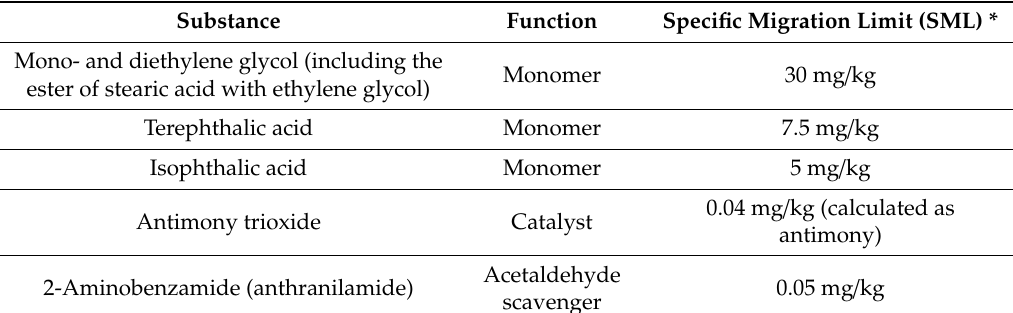
Table 1. Specific migration limits according to the EU Plastics Regulation for compounds used in the manufacture of PET